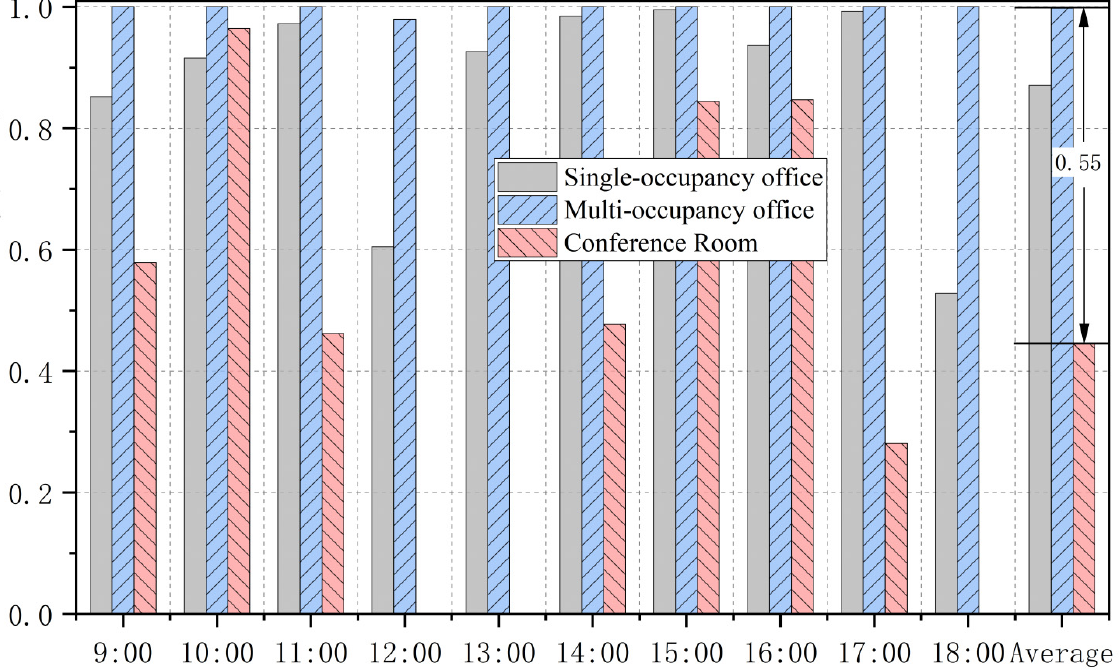
Figure 20. Comparison of ACUP in different types of office space and the variations over time.